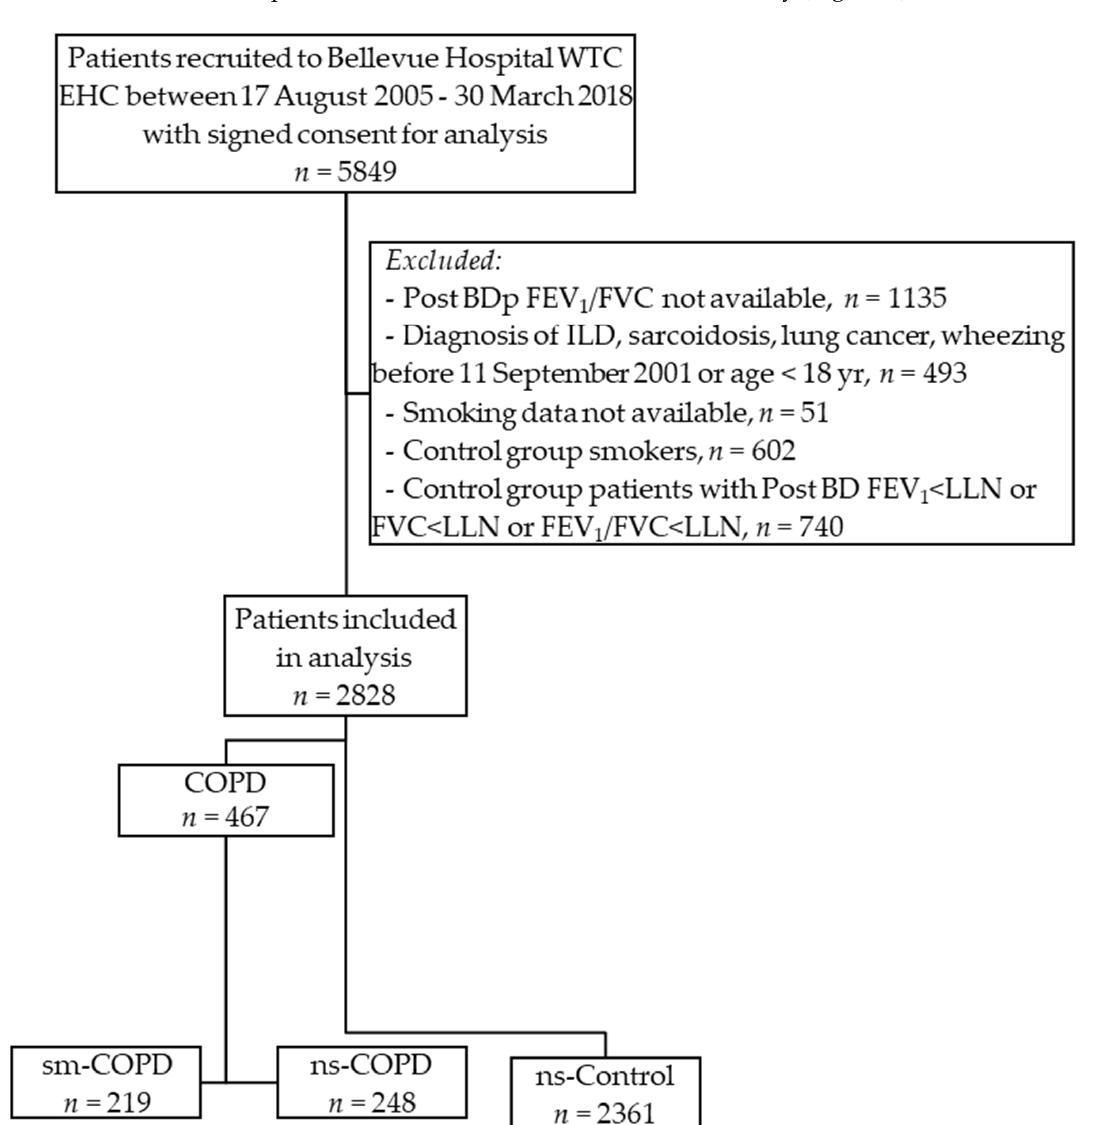
Figure 1. Inclusion and exclusion criteria for the study.